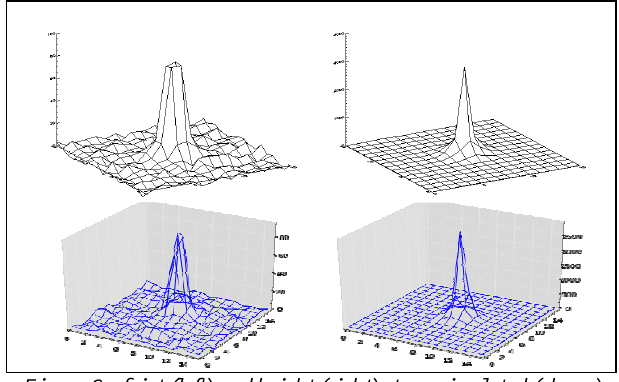
Figure 6 : faint (left) and bright (right) stars, simulated (above) and real